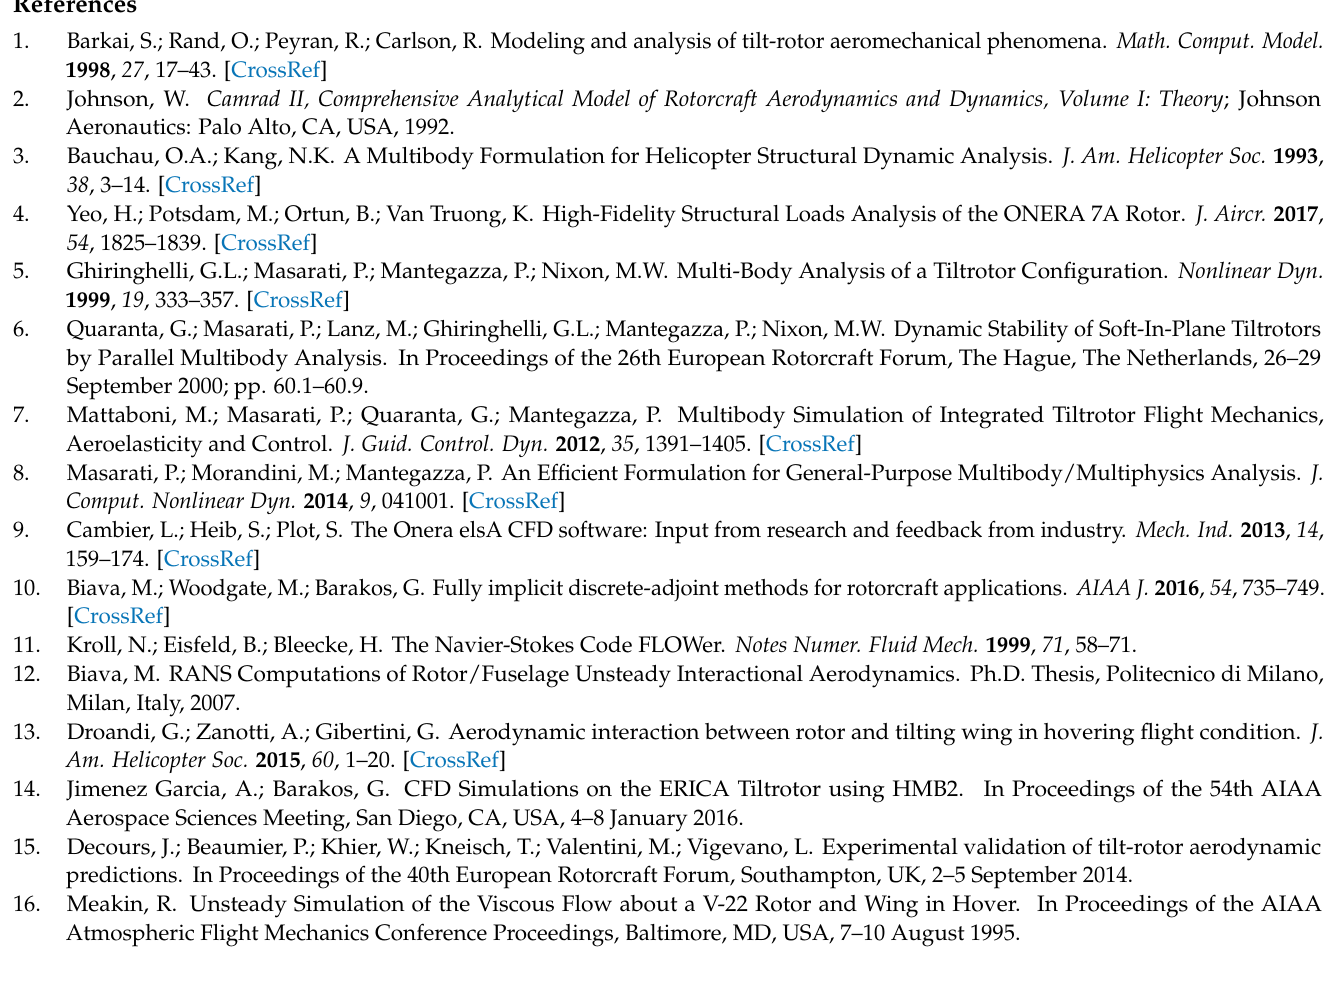
rotor figure of merit = C T √ C T /2/ C